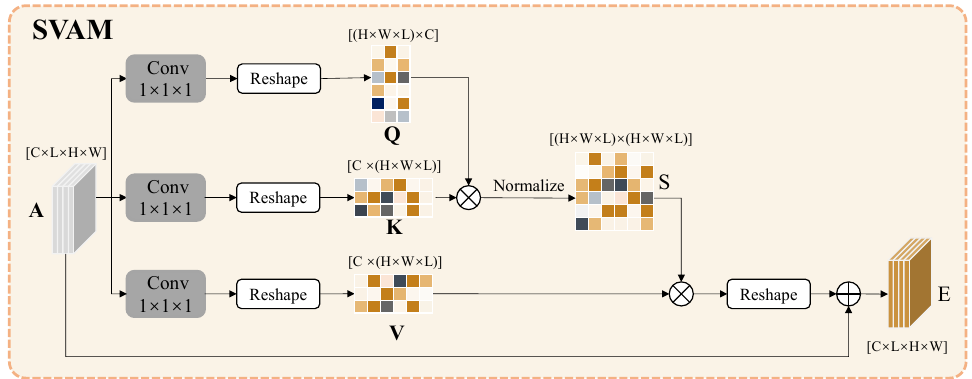
Figure 3. Architecture of SVAM. SVAM is designed for capturing the vision dependence in the spatiotemporal domain. This module takes the feature extracted by I3D as input. Q , K , and V correspond to query, key, and value matrices in the attention mechanism. The output feature is the result of the selective aggregation of features at all positions with the weighted sum of the input features.